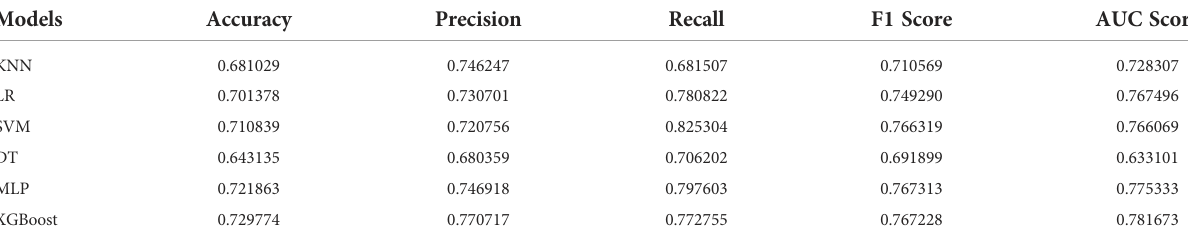
TABLE 3 Performance summary of six machine learning models of